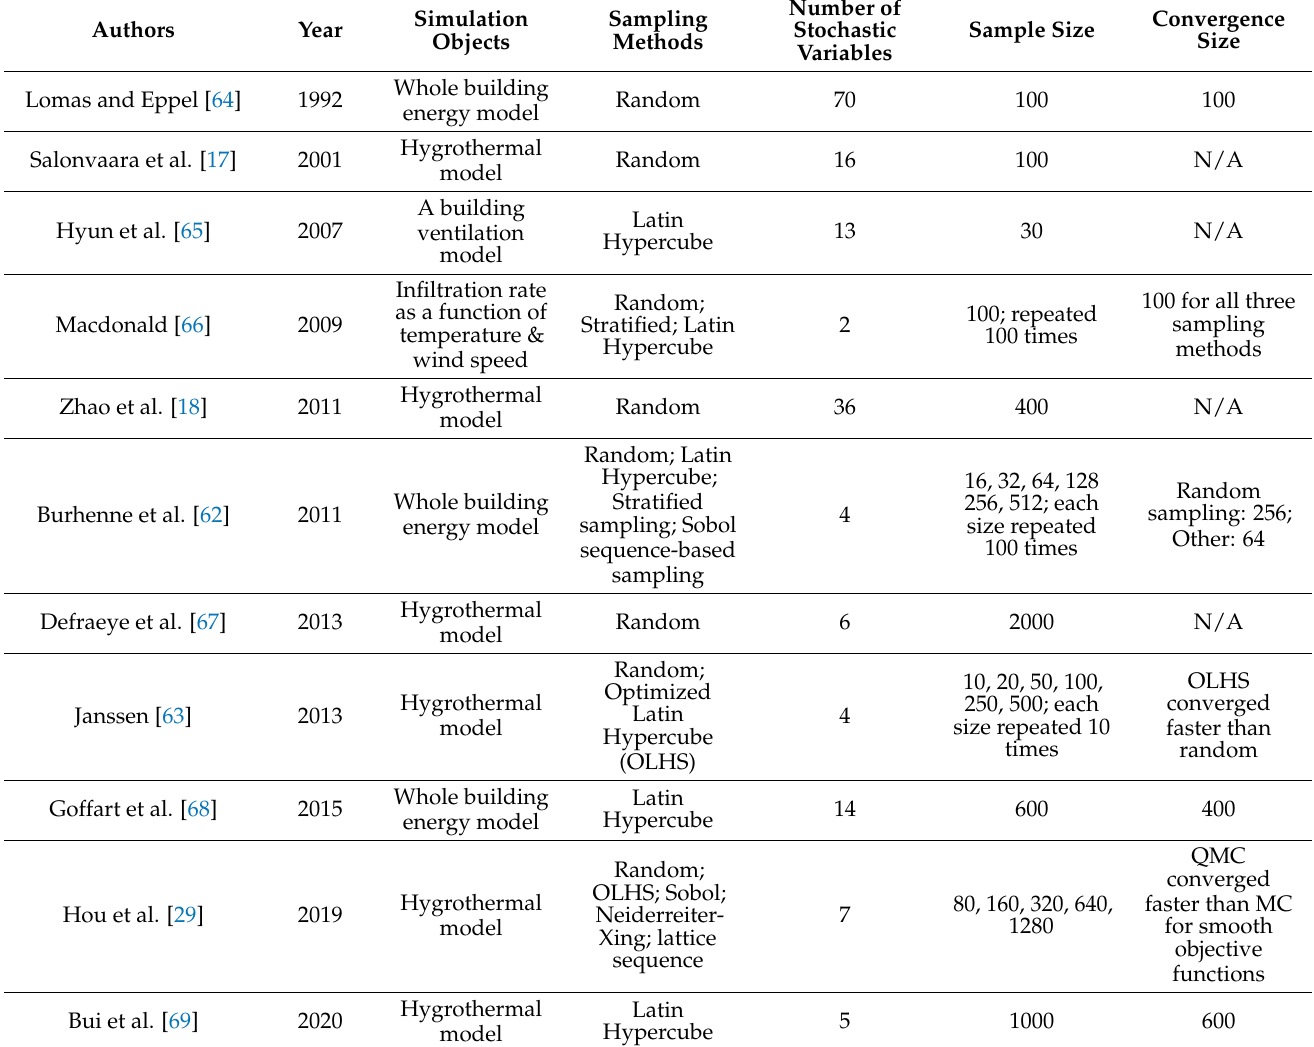
Table 8. Literature review on sampling